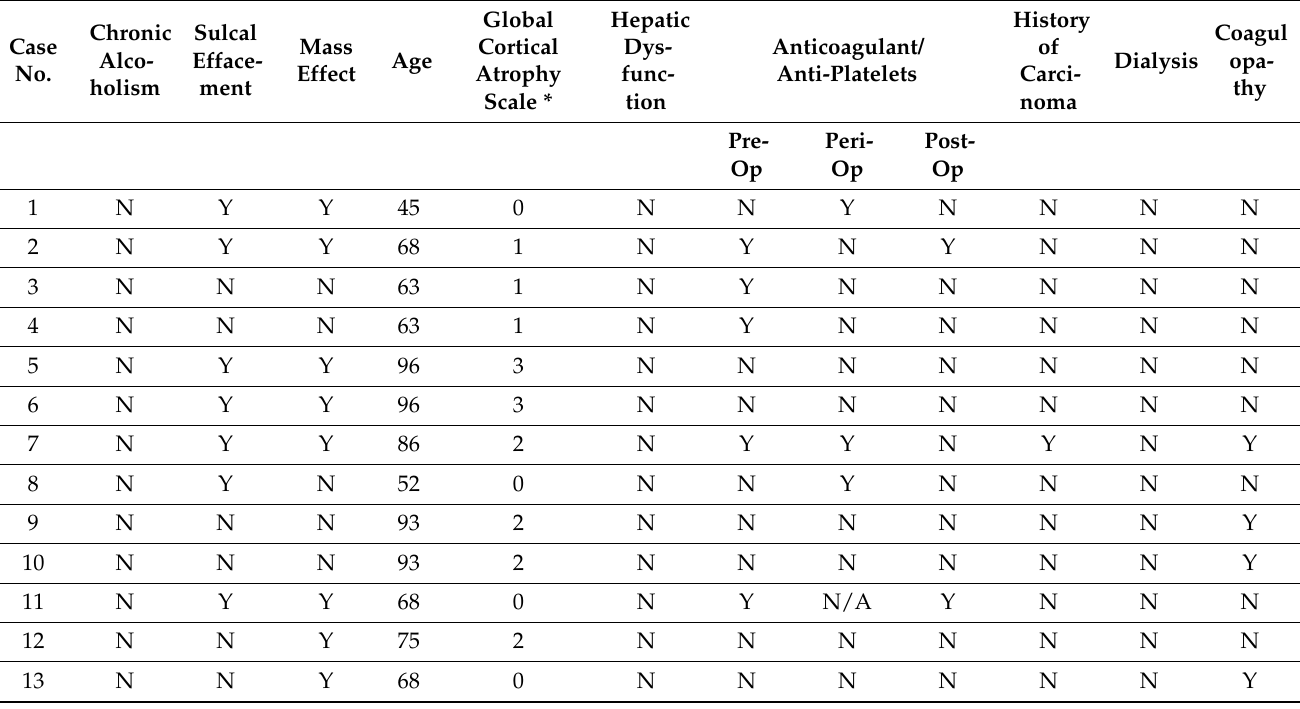
Table 1. Demographic and Clinical